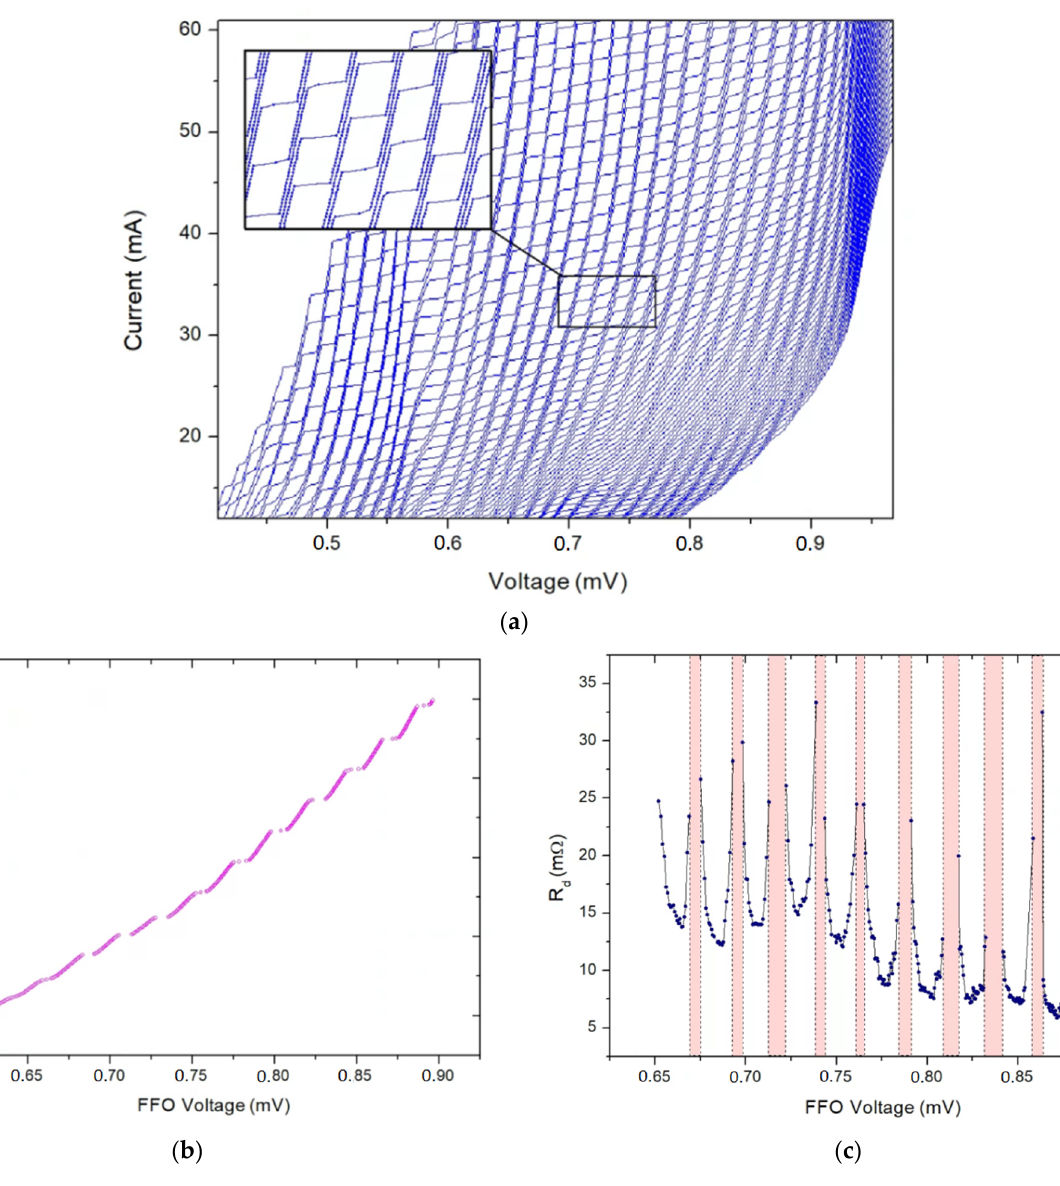
Figure 2. ( a ) IVCs of the Nb-AlO x -Nb FFO measured at different magnetic fields induced by the current in integrated control line (I CL = 20–40 mA); ( b ) IVC of the Nb-AlO x -Nb FFO measured at fixed value of I CL = 29.6 mA; ( c ) differential resistance R d calculated from ( b ) using linear fitting of the IVC over 3 points at each voltage value.